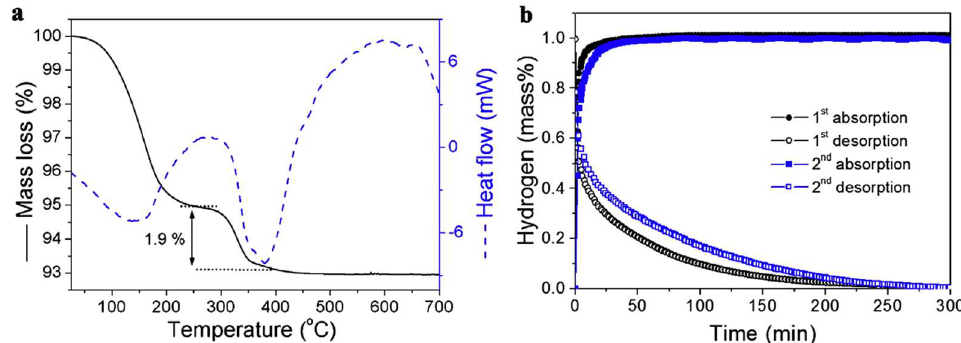
Figure 5. TGA/DSC for LiH@HSAG ( a ) and hydrogen desorption/absorption kinetics for LiH@HSAG at 350 °C ( b ). Reprinted/adapted with permission from Ref. [133]. 2016,